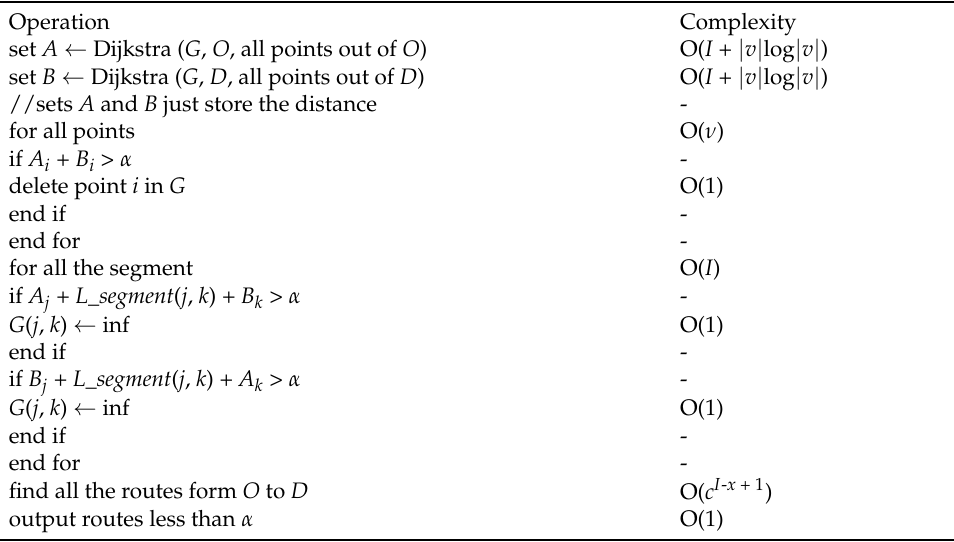
Table 4. Complexity Analysis of Algorithm